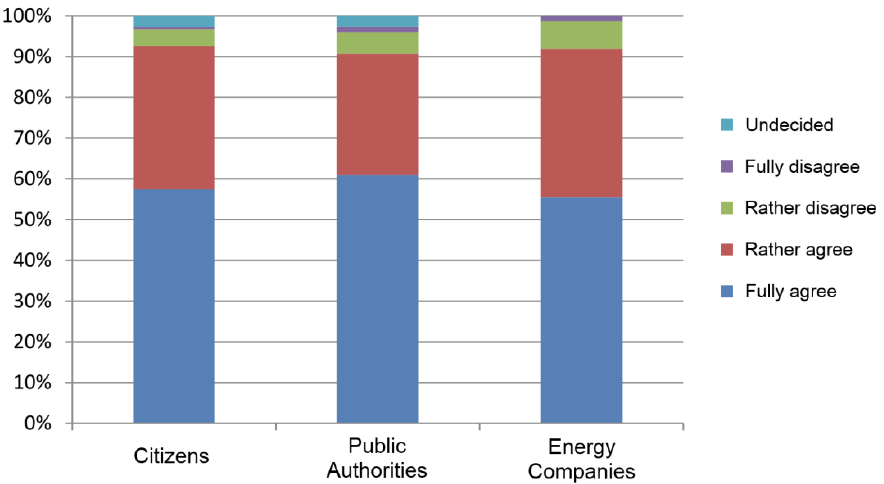
Figure 3. Indications of whether traditional public participation methods should be extended by map-based applications on the Internet (adapted from